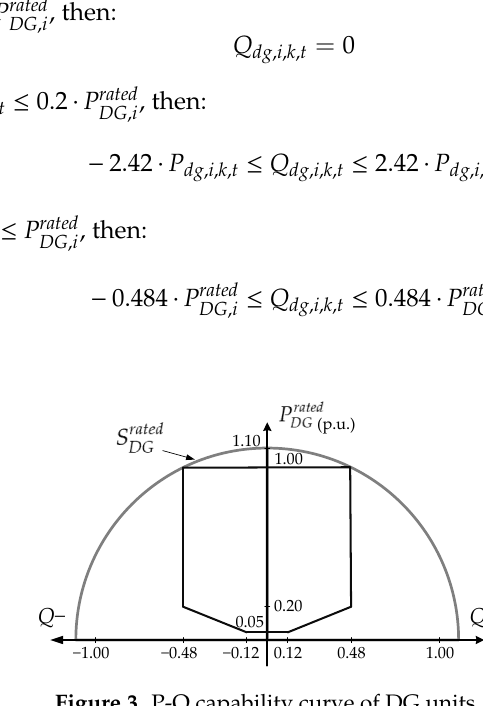
Figure 3. P-Q capability curve of DG units.